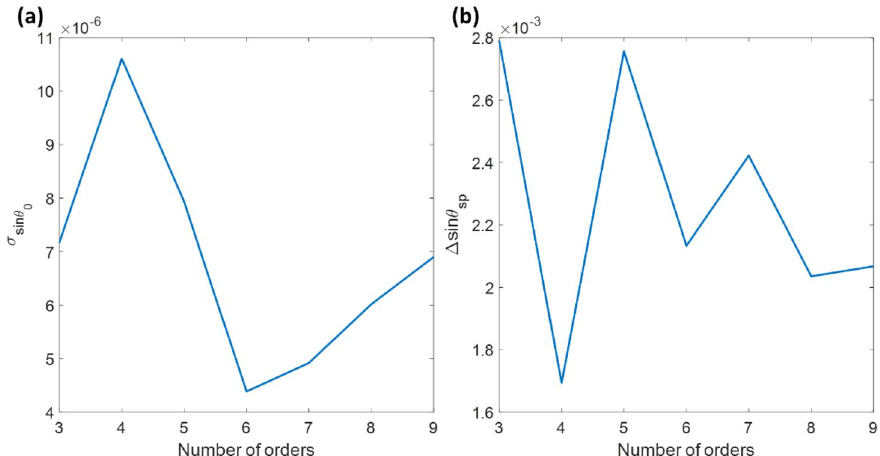
Figure 9. ( a ) σ of 100 recovered sinθ sp values for each data point width, and ( b ) Δsinθ sp between the air and 150 psi cases using Horner’s curve fitting method with varying the n polynomial order from 3 to 9.